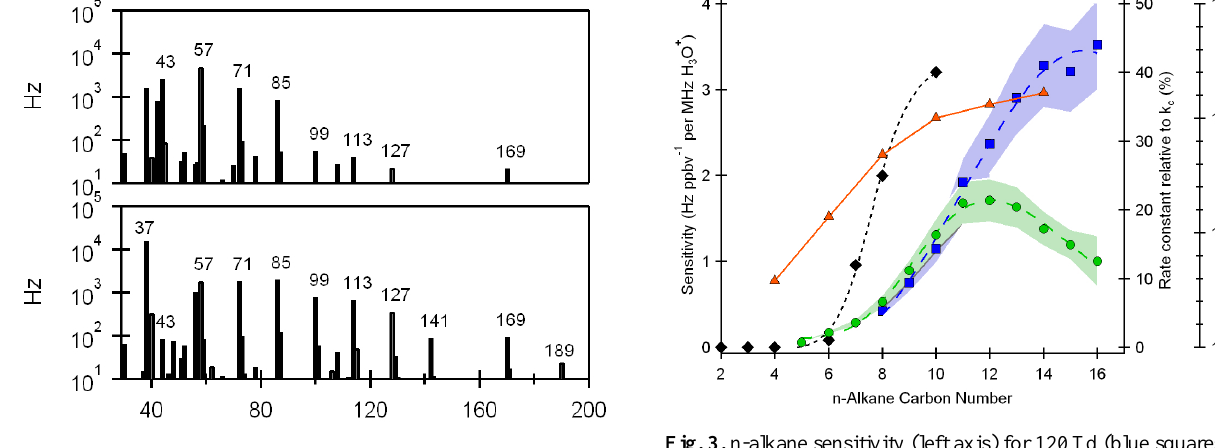
Fig. 3. n-alkane sensitivity (left axis) for 120Td (blue squares) and 80Td (green circles) with shading representing the 15% estimated accuracy of the test mixture preparation. Measured H 3 O + +n- alkane rate coefficients (black diamonds) by Arnold et al. (1998), expressed as a percentage of the collision rate limit (right axis), are shown for trend comparison along with proton affinity (red trian- gles) determined by Hunter and East